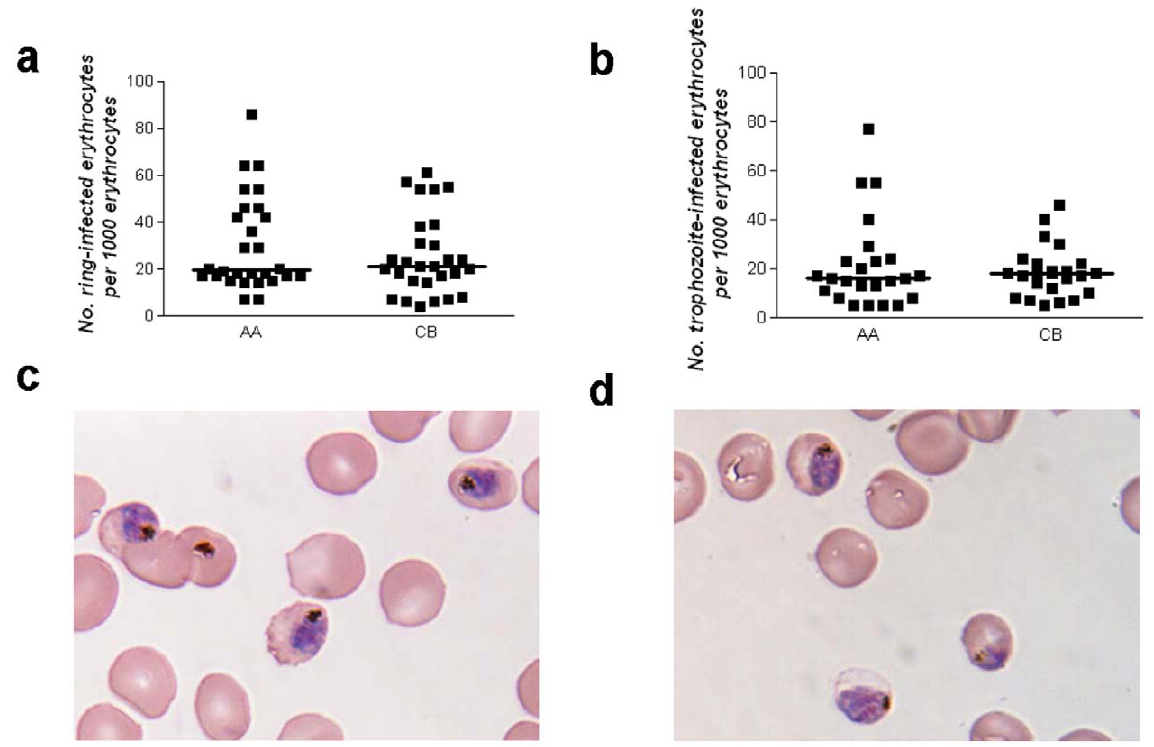
Figure 1. Invasion and development of P.falciparum in RBCs containing HbF. a , P. falciparum invasion of RBCs. The numbers of ring-infected RBCs per 1000 AA or CB RBCs are shown. Median values are indicated by horizontal bars. b , P. falciparum development in RBCs. The numbers of trophozoite-infected RBCs per 1000 AA or CB RBCs are shown. Median values are indicated by horizontal bars. Results in a and b were obtained from 5 parasite lines (7G8, GB4, MC/R + , FVO, TM284) and multiple blood donors (4AA, 6CB) (not all combinations tested). c, d , The photomicrographs show mature parasites in AA ( c ) and HPFH ( d ) RBCs (containing 100% HbF) that are morphologically normal and synchronously developed.